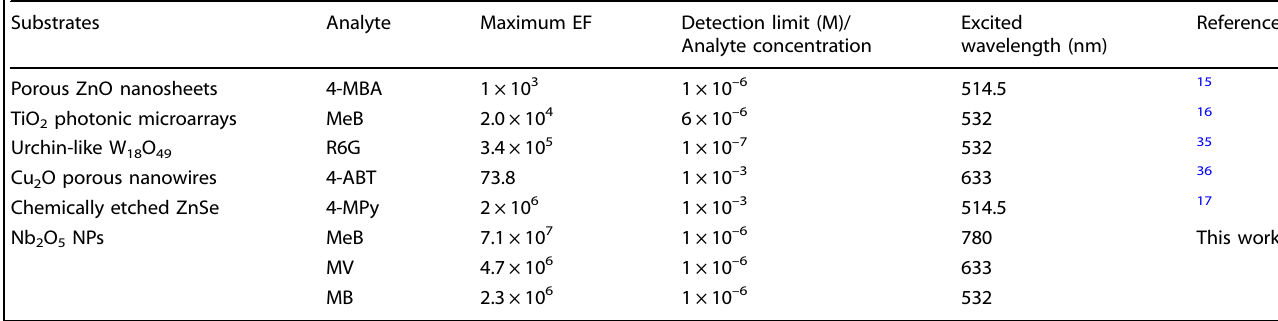
Table 2. Performance of semiconductor SERS active materials from literatures Substrates